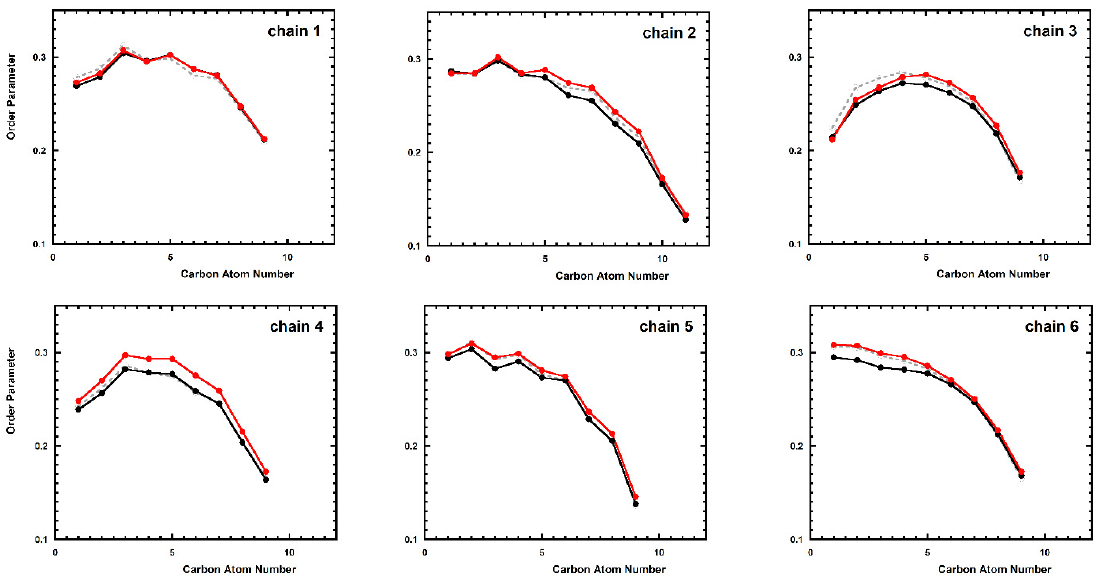
Figure 5. Deuterium order parameter for the six lipid chains of the lipid-A calculated starting from the structures in the global minimum of the PMF profile. Black, red and dashed-gray lines refer to TempL, Q3K-TempL, and unperturbed bilayer, respectively.